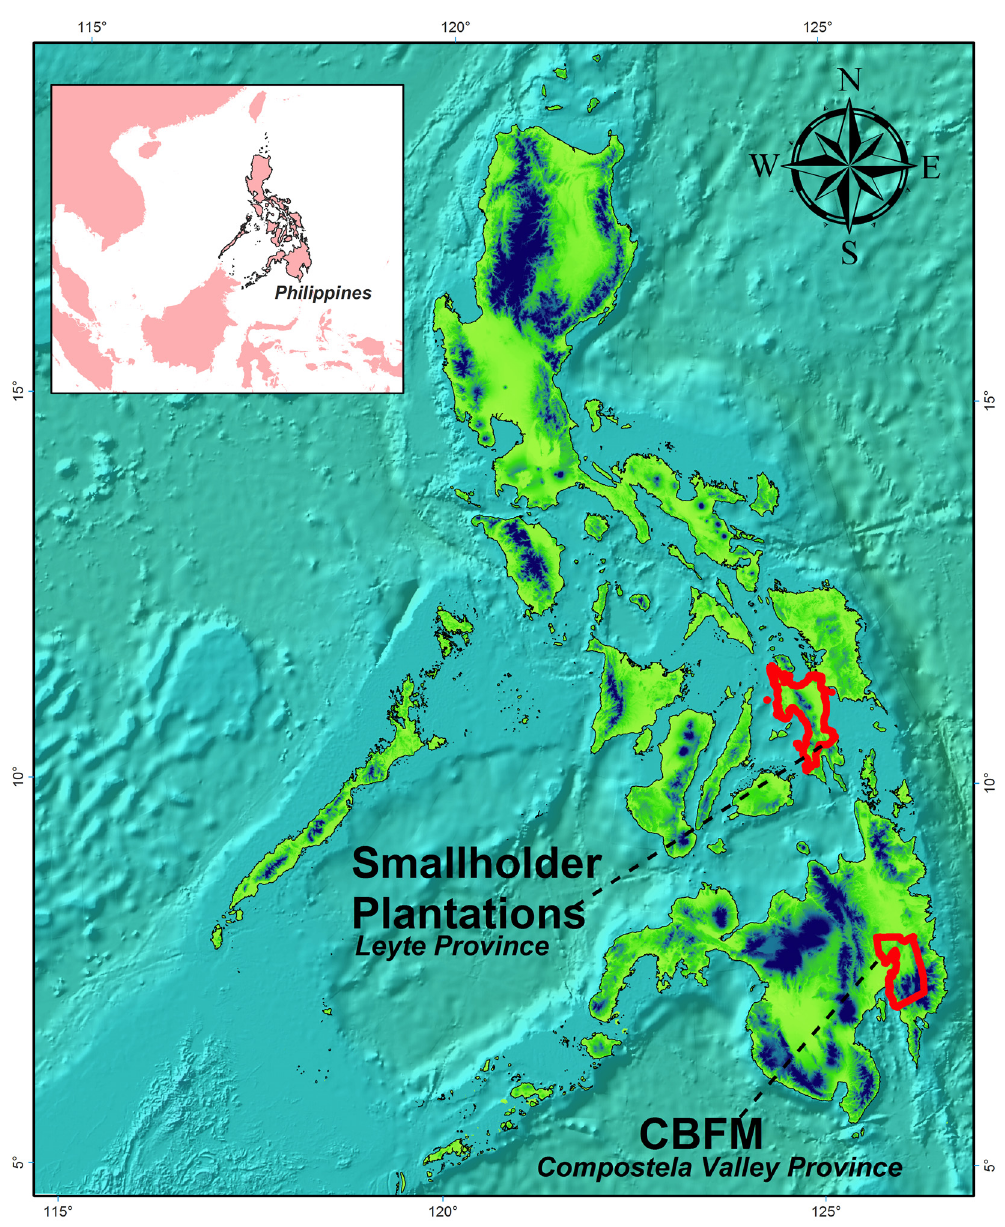
Figure 2. Location map of the study sites.